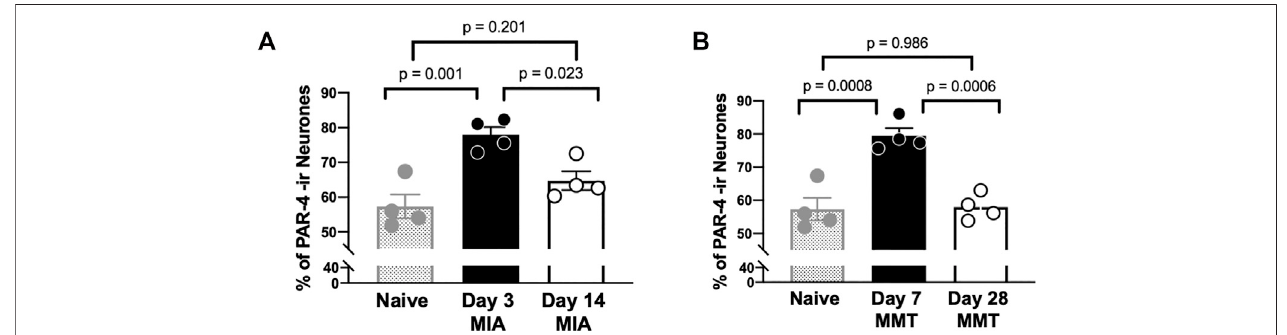
FIGURE 4 | PAR4 Expression is Elevated in Early OA/PTOA. The percentage of PAR4 expressing joint neurons was signi fi cantly higher in day 3 MIA compared to day14 (A) ( p < 0.01,student ’ s t -test, n (cid:1) 4animalspergroup).Similarly,higherlevelsofPAR4wereobserved7 daysfollowingMMTsurgerycomparedtoDay28 (B) ( p < 0.001, student ’ s t -test, n (cid:1) 4 animals per group). Data are means ± SEM.